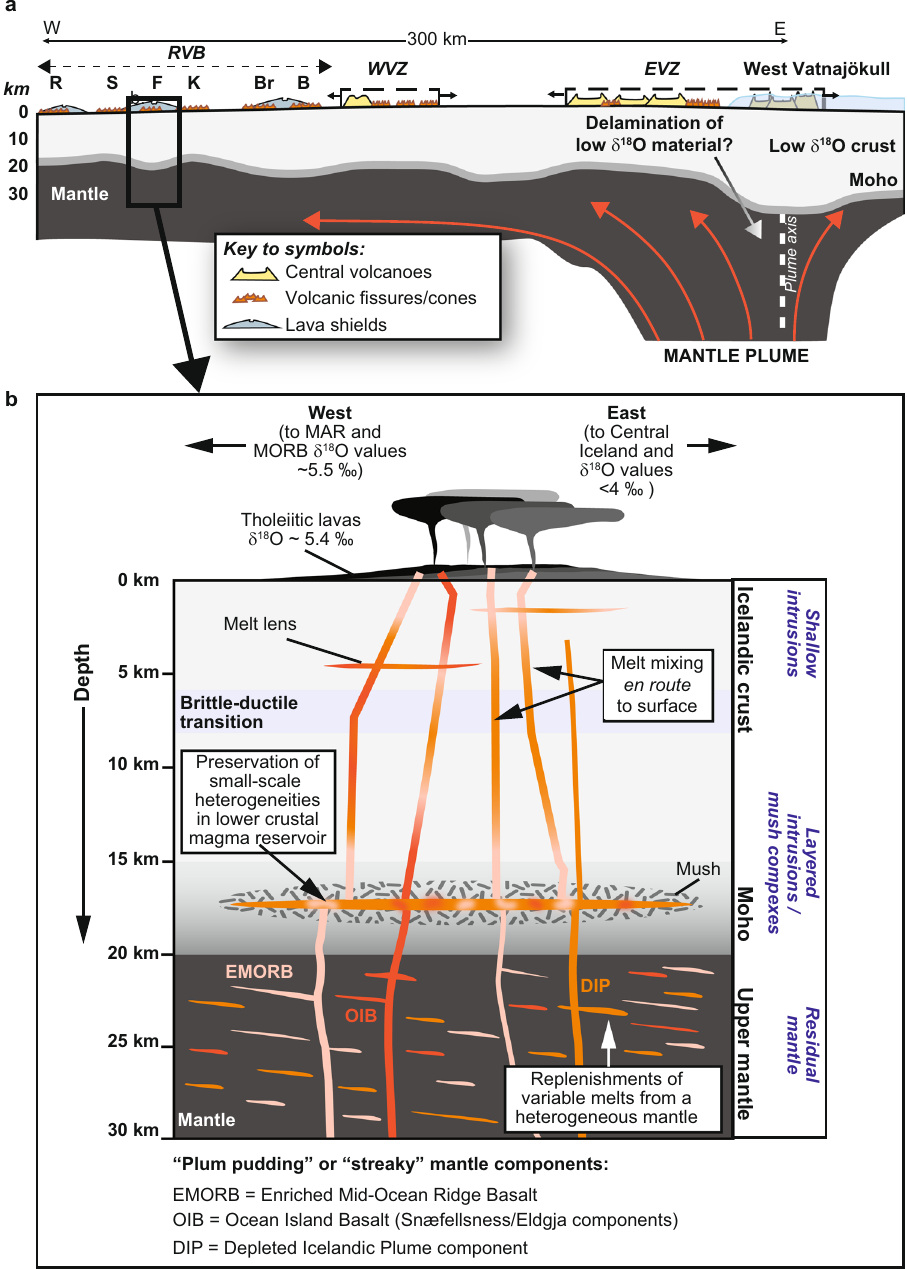
Fig. 7 Schematic model. a Sketch placing Fagradalsfjall (F) in a regional context in relation to the Reykjanes Volcanic Belt (RVB), the Western Volcanic Zone (WVZ), and the Eastern Volcanic Zone (EVZ) of Iceland (see Fig. 1 for map view of Iceland). b Close-up of Fagradalsfjall showing a heterogeneous “ plum pudding ” or “ streaky ” mantle comprising various source components such as EMORB, OIB, and DIP. Variable melts from this heterogeneous mantle were assembled in a lower crustal magma reservoir, which likely experienced multiple replenishment episodes leading to complex mineral zoning. Mixing of melts shortly before eruption facilitated preservation of compositional heterogeneities inherited from the mantle source. Remarkably, despite the variability in the compositions of Fagradalsfjall erupted products, their δ 18 O values are homogeneous at 5.4 ‰ on average with no evidence for low- δ 18 O mantle or interaction with low- δ 18 O crust. The mean δ 18 O value for Fagradalsfjall may thus represent a useful mantle reference in this part of the Iceland plume system. Abbreviations: B Bláfjöll, Br Brennisteinsfjöll, K Krýsuvík, MAR Mid-Atlantic Ridge, MORB Mid-Ocean Ridge Basalt, R Reykjanes, S Methods laser fl uorination. Puri fi ed O 2 was converted into CO 2 and then run in dual inlet Oxygen isotopes ( δ 18 O and Δ ′ 17 O) . All oxygen isotopic data in this study were mode on a MAT253 mass spectrometer integrated with a vacuum line. San Carlos Olivine ( δ 18 O = 5.25 ‰ ), UWG2 garnet ( δ 18 O = 5.80 ‰ ) and an indoor UOG obtained at the University of Oregon (UO), Eugene, Oregon, USA. Detailed garnet standard calibrated relative to the other two ( δ 18 O = 6.52 ‰ ) were used to method descriptions can be found in refs. 37,45,46 and are summarised here. Oxygen calibrate the data on the VSMOW scale. Each session included analyses of four to isotope measurements for δ 18 O utilised 1 to 1.5mg of glassy sample material and six standards and correction for day-to-day variability was 0.0 to 0.2 ‰ . Reference were performed by laser fl uorination and gas-source mass spectrometry CO 2 gas was used as a working standard and it was periodically rerun against (MAT253). Puri fi ed BrF 5 was used as a reagent and a boiling mercury diffusion OZTECH CO 2 gas. Standard deviations on standards in individual sessions ranged pump was used to remove excess F 2 gas remaining after reaction of BrF 5 during